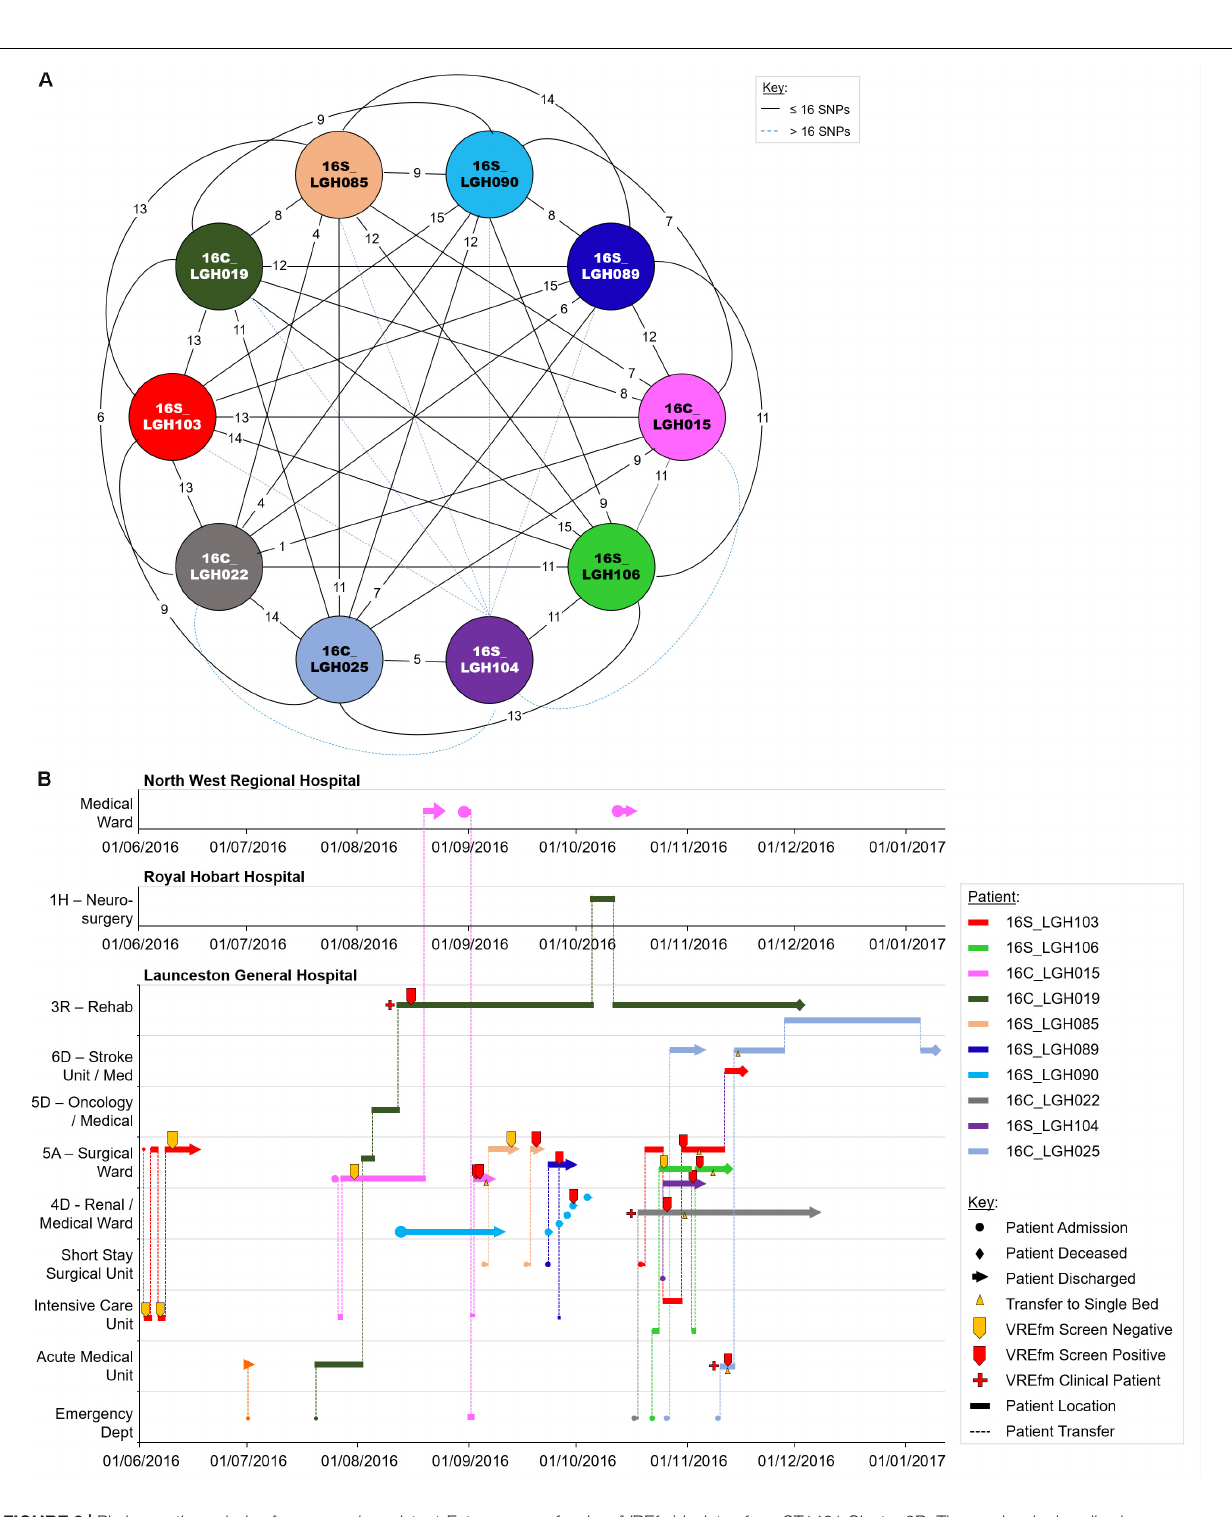
Frontiers in Microbiology |